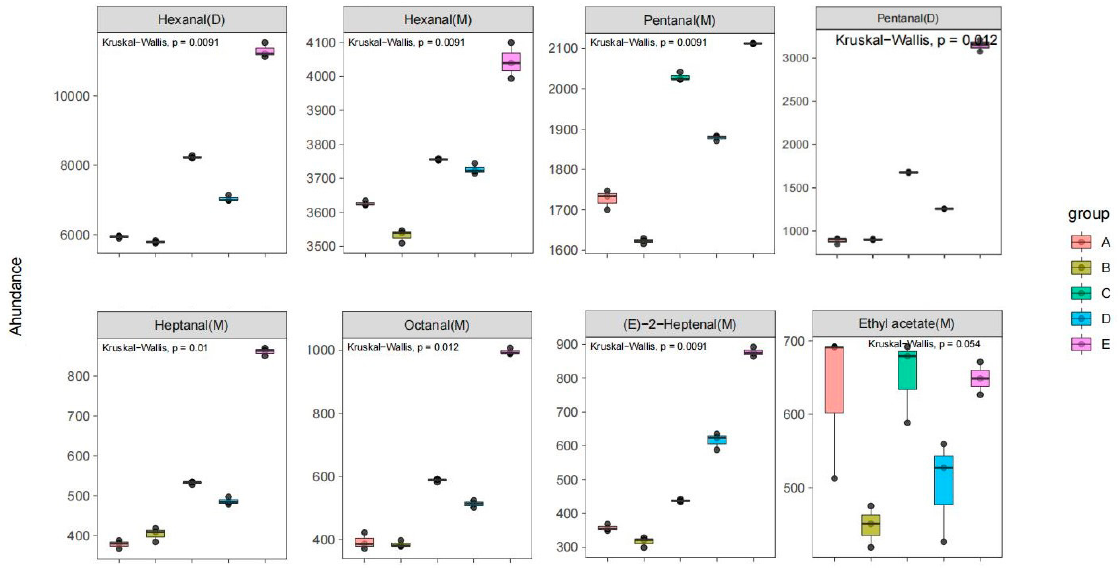
Figure 5. Box plot of key VOCs (relative content) in walnut oil from five different varieties